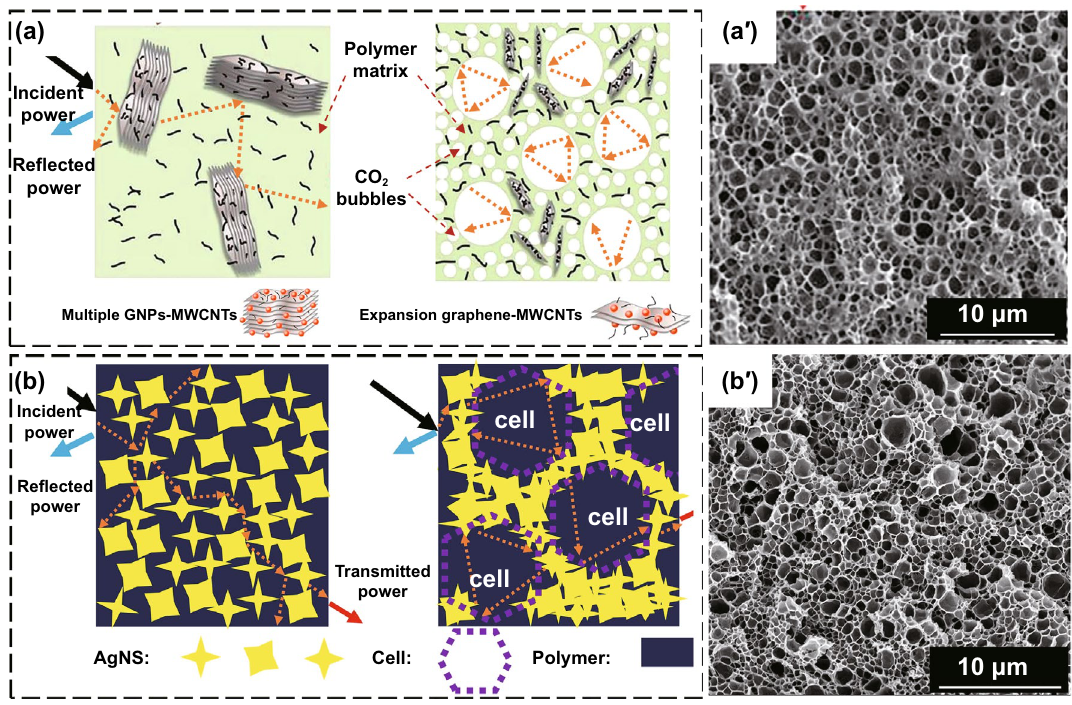
Fig. 8 Schematic diagram and SEM images of a PMMA/GNPs-MWCNTs and b AgNS/epoxy composites with homogeneous and porous struc- tures [106, 107]. Copyright © 2018 Elsevier. Copyright © 2019